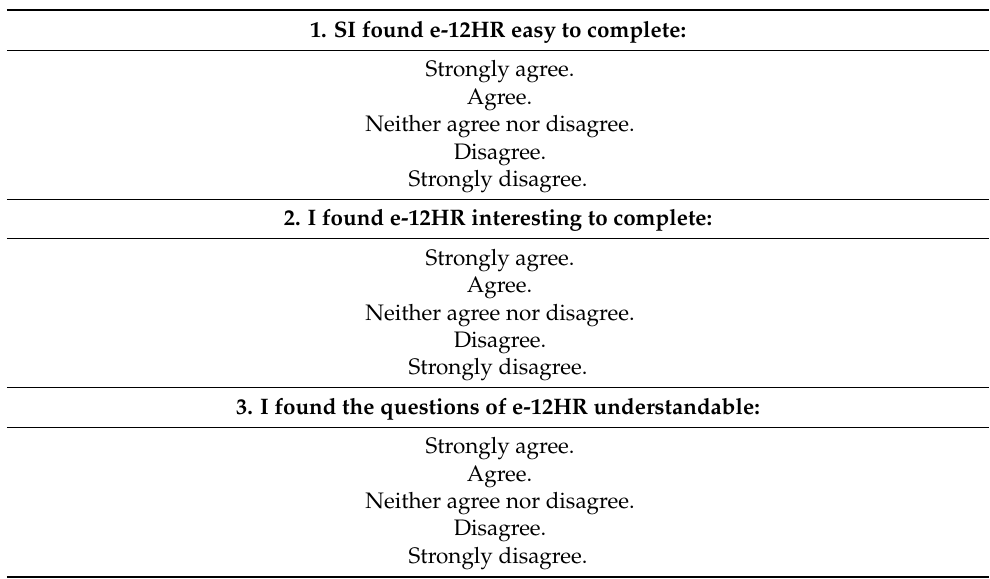
Table A2. Usability rating questionnaire for